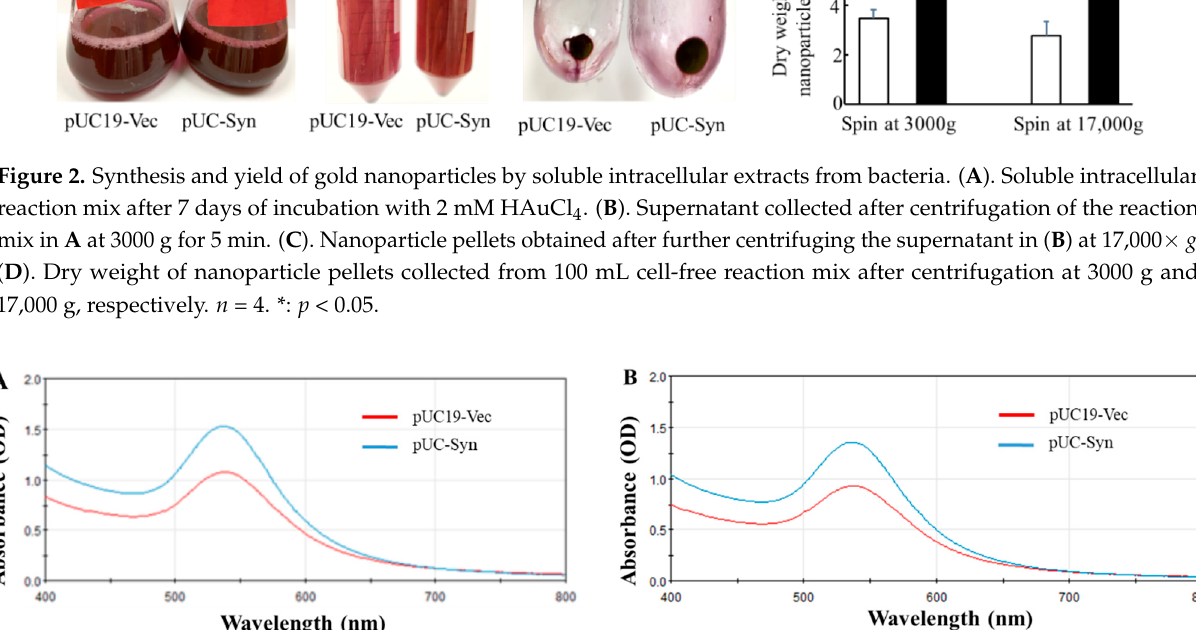
Figure 3. UV-vis spectra of nanoparticles. ( A ). UV-vis spectra of reaction mix containing soluble intracellular extracts before centrifugation. ( B ). UV-Vis spectra of supernatant collected after centrifugation of reaction mix at 3000 × g for 5 min.